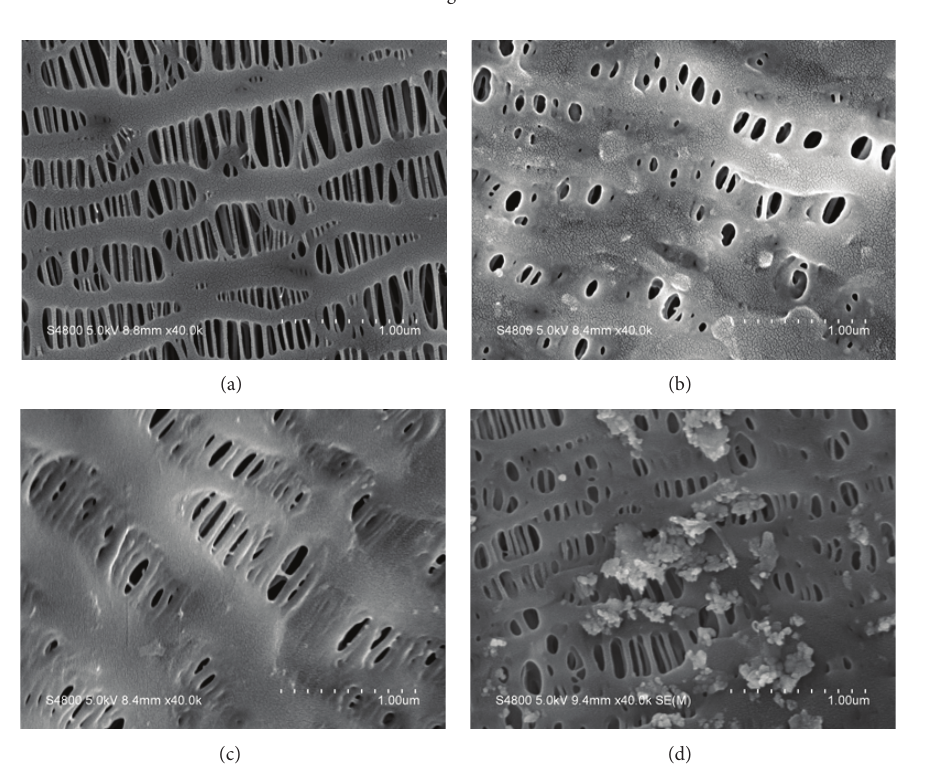
Figure 4: FESEM images ( ×40000 ) of (a) the unmodified, and (b)-(c) PHEMA grafted PPMMs with GD = 2.40 and 4.05% (wt), respectively; (d) ZnONPs immobilized PPMMs with GD = 36.0 % (wt), ID = 6.2 %